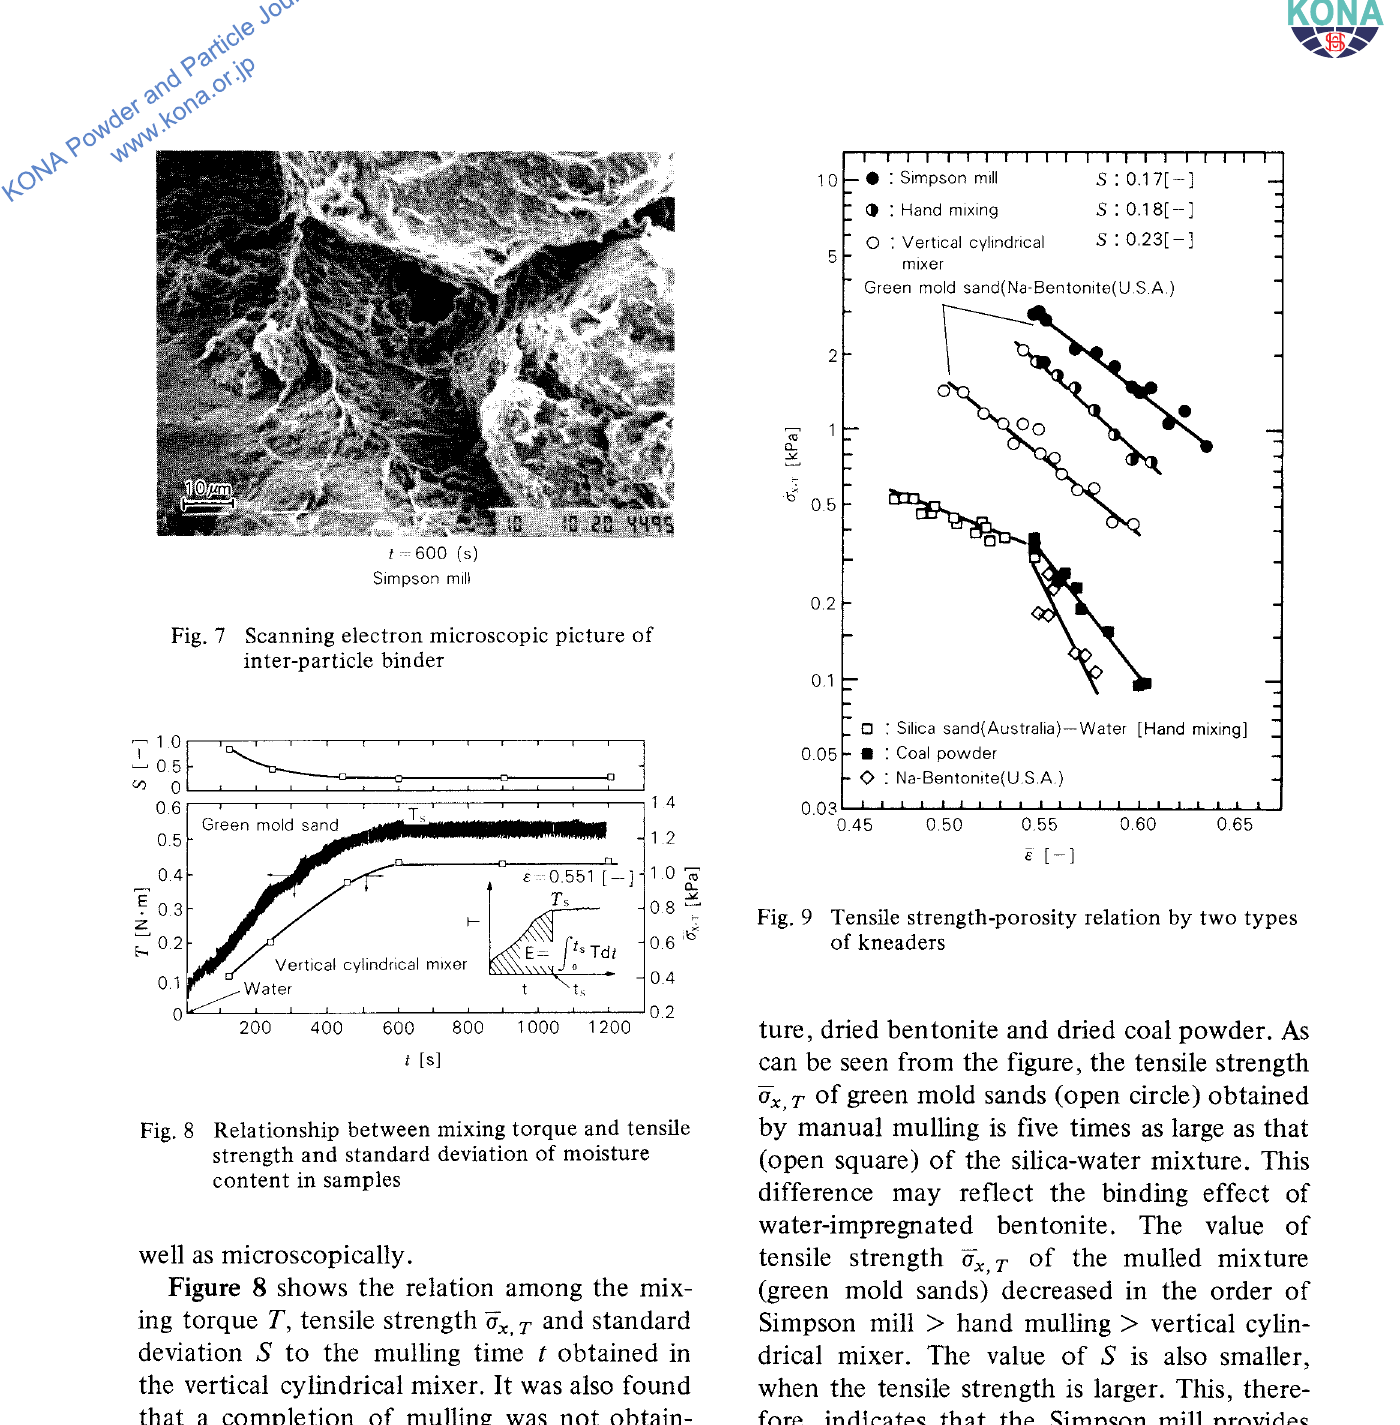
Fig. 8 Relationship between mixing torque and tensile strength and standard deviation of moisture content in samples